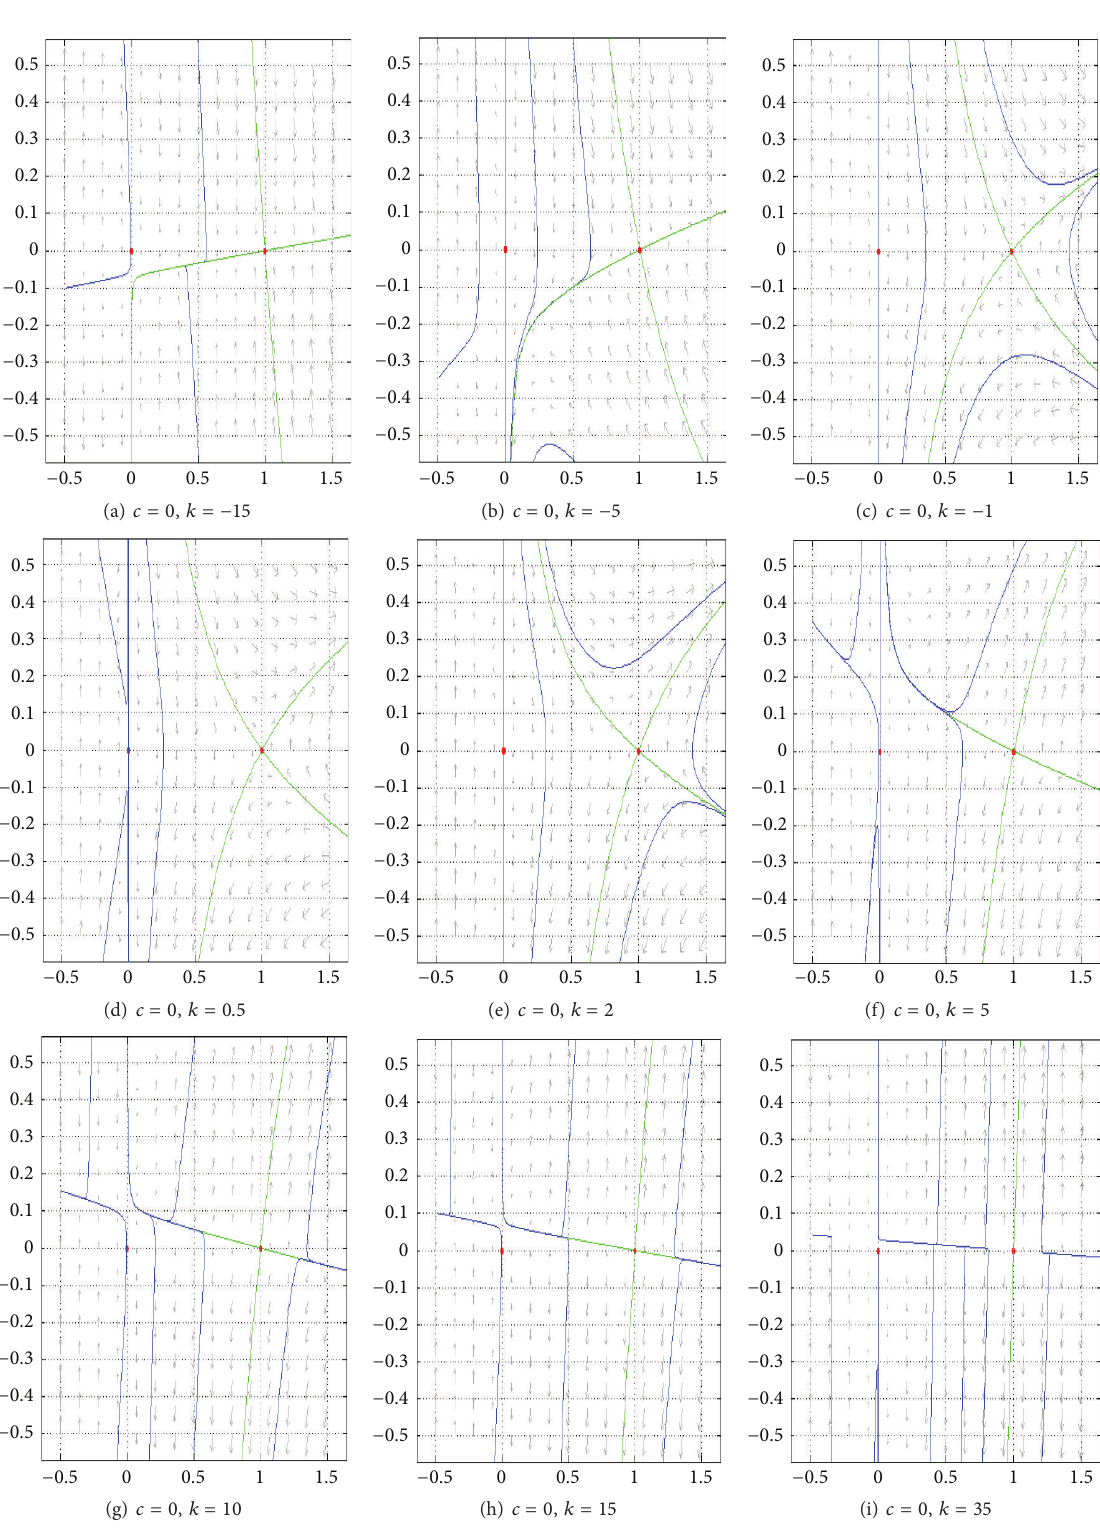
Figure 5: Phase portraits of system (27) for 𝑐 = 0 and for the same positive values of 𝑘 as those in Figure 4. Red points are equilibrium points. Green curves are nullclines and blue curves are